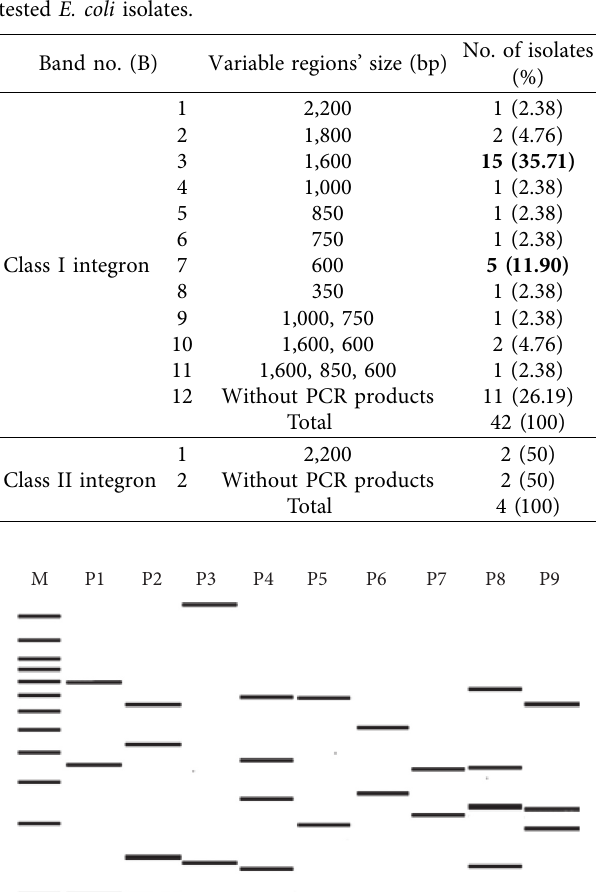
Figure 2: Schematic representation of the patterns obtained by digestion of integron I and II regions by HinfI restriction enzyme.